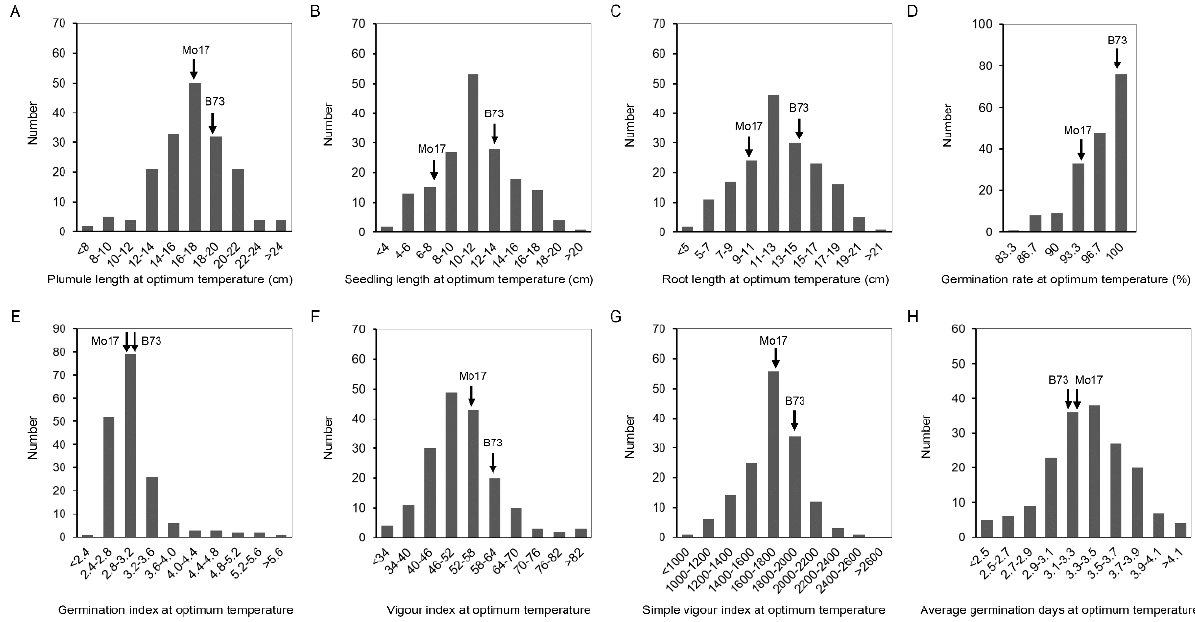
Figure 2. The histogram of frequency distribution of germination-related traits under 25 °C in IBM Syn10 DH population. ( A ) Plumule length at optimum temperature (OTPL); ( B ) seedling length at optimum temperature (OTSL); ( C ) root length at optimum temperature (OTRL); ( D ) germination rate at optimum temperature (OTGR); ( E ) germination index at optimum temperature (OTGI); ( F ) vigor index at optimum temperature (OTVI); ( G ) simple vigor index at optimum temperature (OTSVI); ( H ) average germination days at optimum temperature (OTAGD).